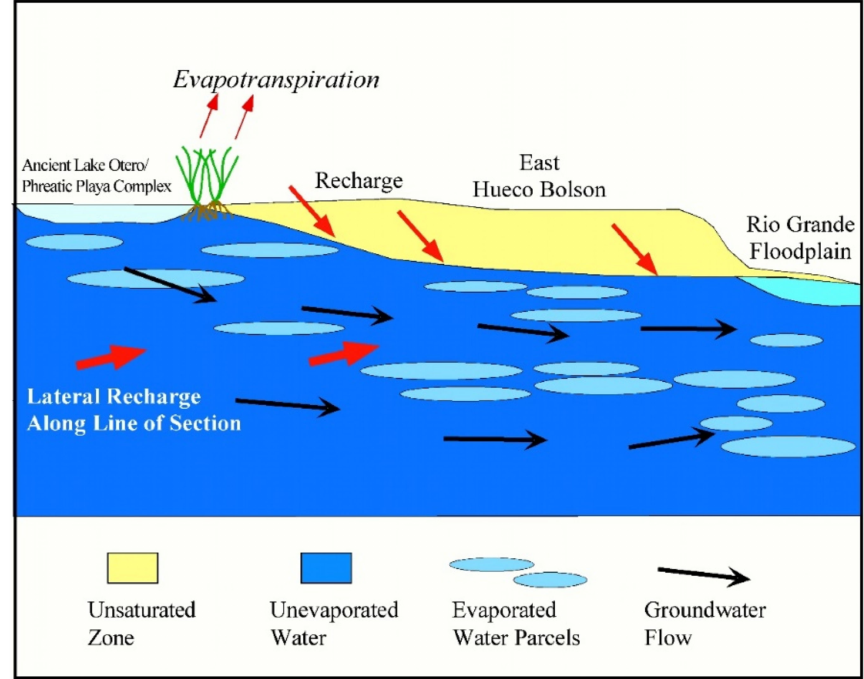
Figure 14. Conceptual model for groundwater flow from a partially evaporated (or enriched) water source near historic Lake Otero, extending across the Tularosa Bolson into the east Hueco Bolson and moving to the El Paso-Juarez Valley (Rio Grande